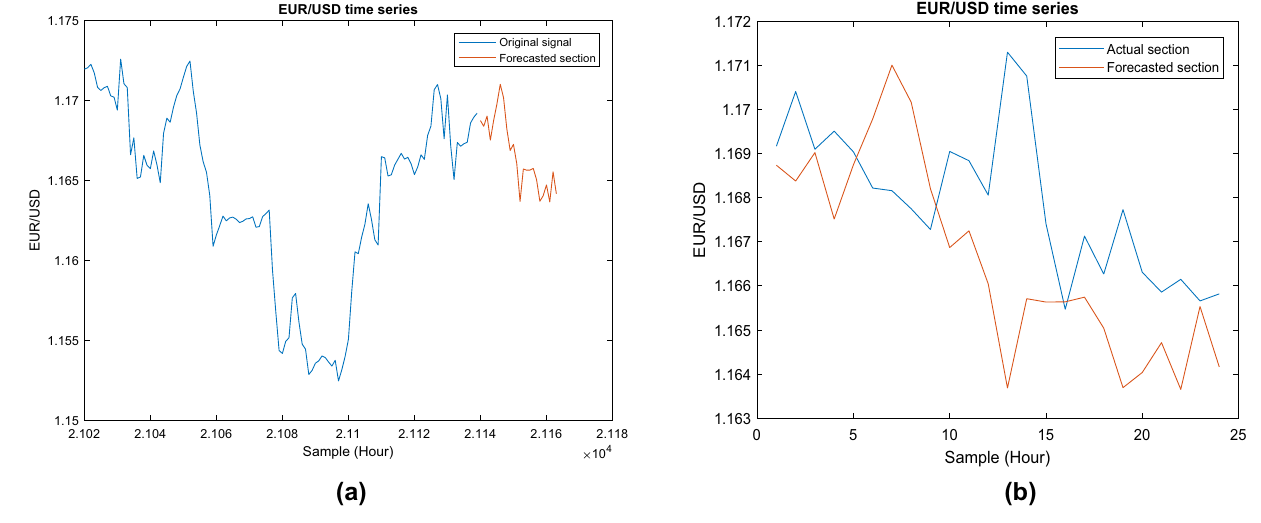
Fig. 2 a Forecasting the upcoming 24 data samples of the EUR/USD exchange rate using the apriori 120 data samples. b Comparison of the forecasted data [24 samples (hours)] with the actual data. There is reasonable forecasting accuracy with a correlation coefficient of